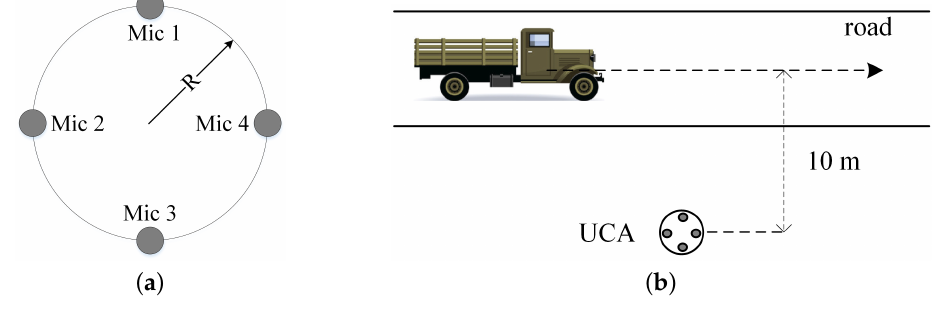
Figure 3. Illustration of the experimental scenario. ( a ) The arrangement of the four-element microphone uniform circular array (UCA); ( b ) Layout of the experiment in the